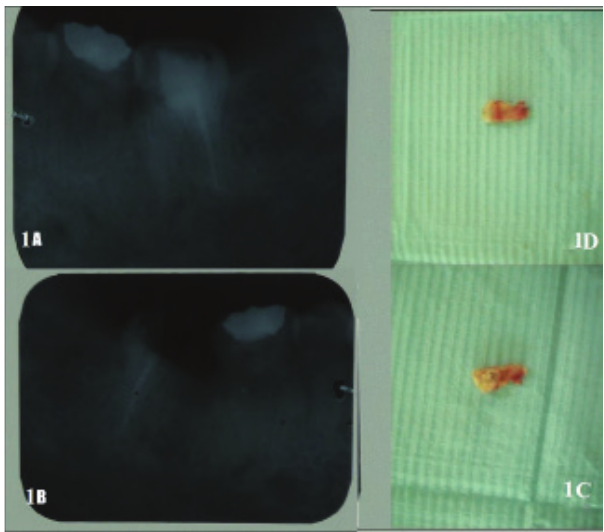
Figure-I: Pre-op radiograph (A), Retained distal root after hemisection (B), Distal view of mesial root (C), Mesial view of mesial root (D).